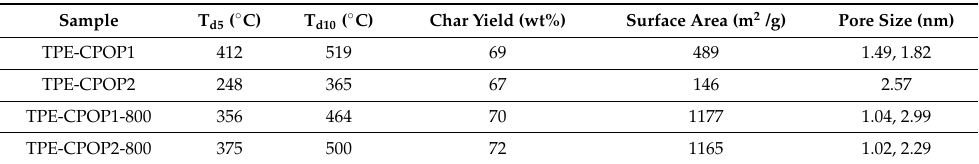
Table 1. Thermal stability and porosity properties of TPE, TPE-CPOP1, TPE-CPOP2, TPE-CPOP1-800, and TPE-CPOP2-800. Figure 3. TGA diagram of ( a ) TPE-CPOP1 and ( b ) TPE-CPOP2, ( c ) TPE-CPOP1-800, and ( d ) TPE- CPOP2-800.